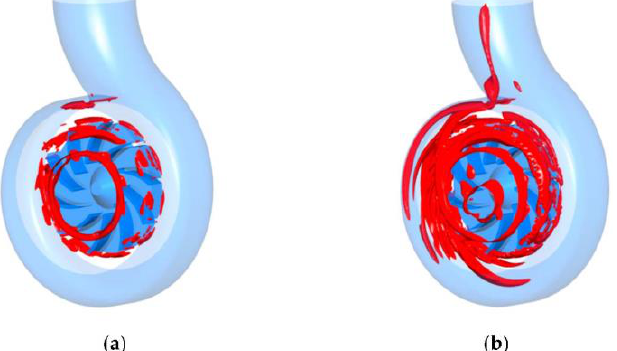
Figure 11. Hn of blades, interface and middle plane: ( a ) Impeller middle section; ( b ) Blade and interface.